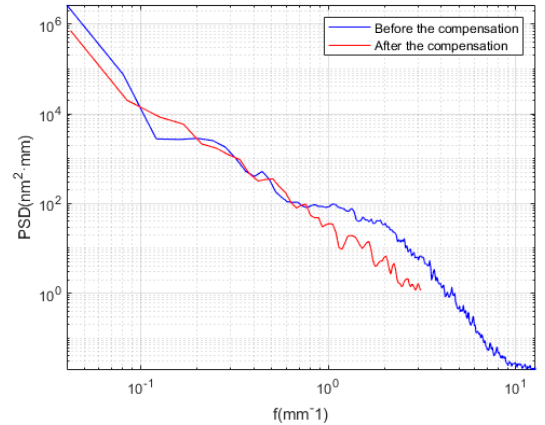
Figure 10. Comparison of particle size distribution curves before and after compensation.